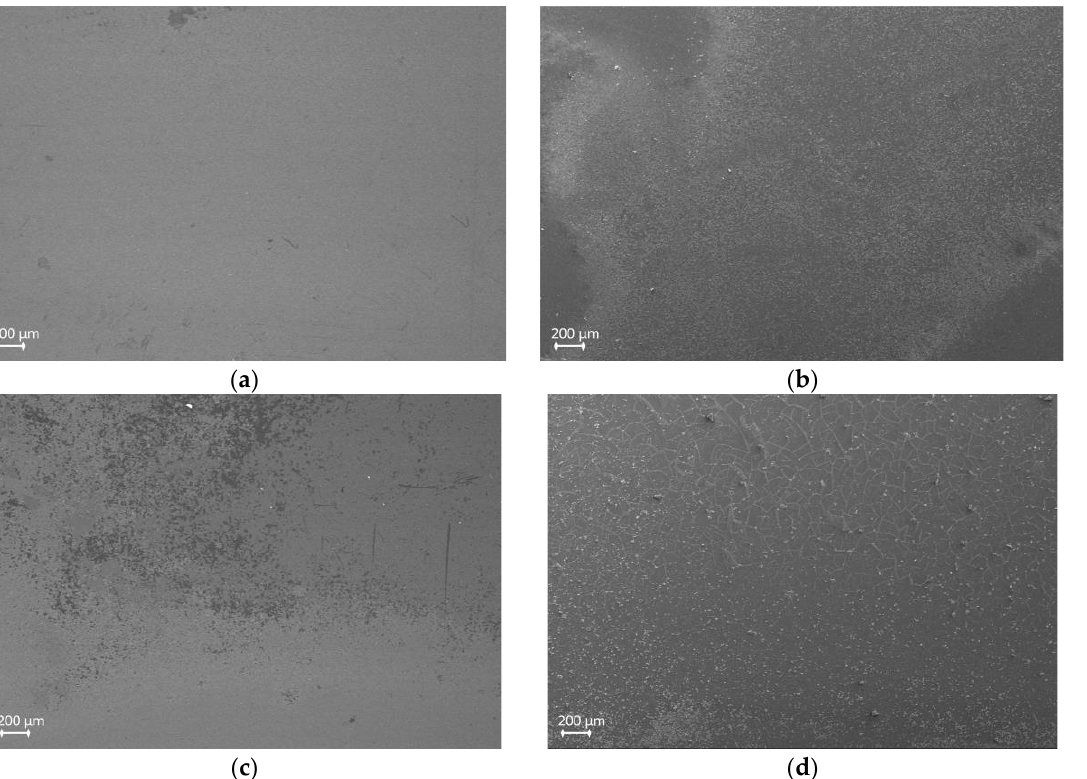
Figure 11. SEM images of annealed coatings before ( a ) and after ( b ) annealing, and of nonannealed coatings before ( c ) and after ( d ) annealing.